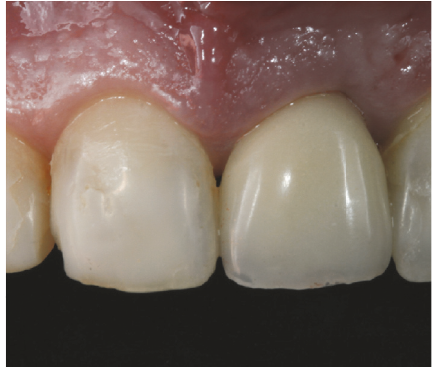
Figure 7: Operated area after 15 days demonstrating the mainte- nance of the gingival